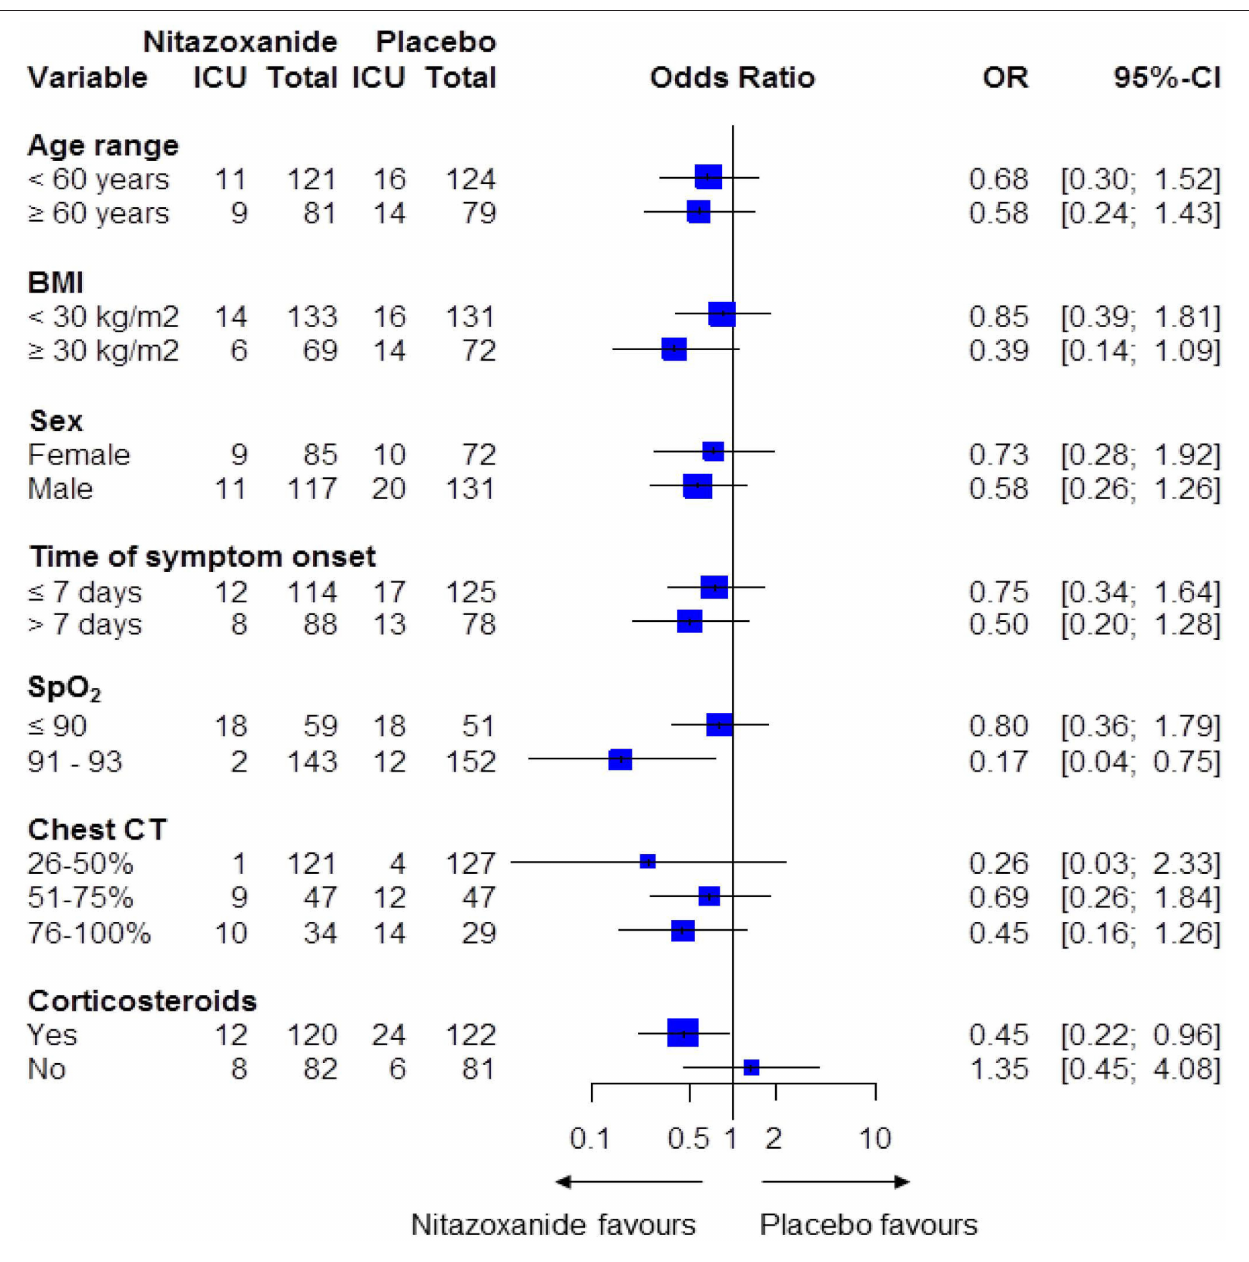
FIGURE 4 | Forest plot according to the primary outcome in the nitazoxanide and placebo groups. BMI, body mass index; CI, confidence interval; OR, odds ratio; SpO 2 , peripheral saturation of oxygen. ORs and 95% CIs were calculated for each category